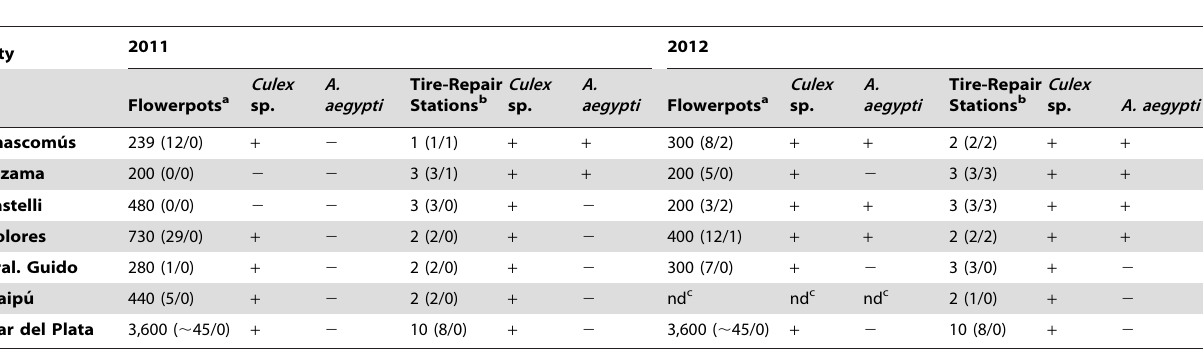
Table 2. Sampling stations and species collected in cities along Route N u 2, in the southeast of Argentina.